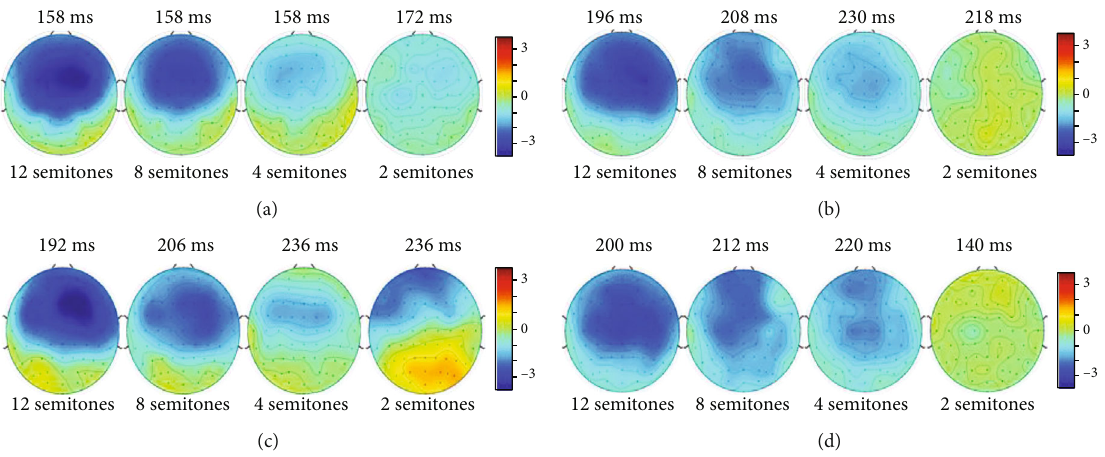
Figure 2: Contour maps of MMN amplitude for grand-average di ff erences in waveforms for NH listeners (a) and CI users (b) and CI users with good (c) and poor (d) performance. Topological distributions are displayed at latencies with peak MMN amplitudes in each plane.